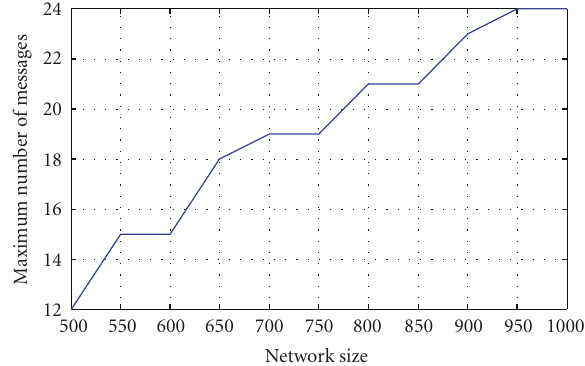
Figure 6: Maximum number of messages received by a node versus network